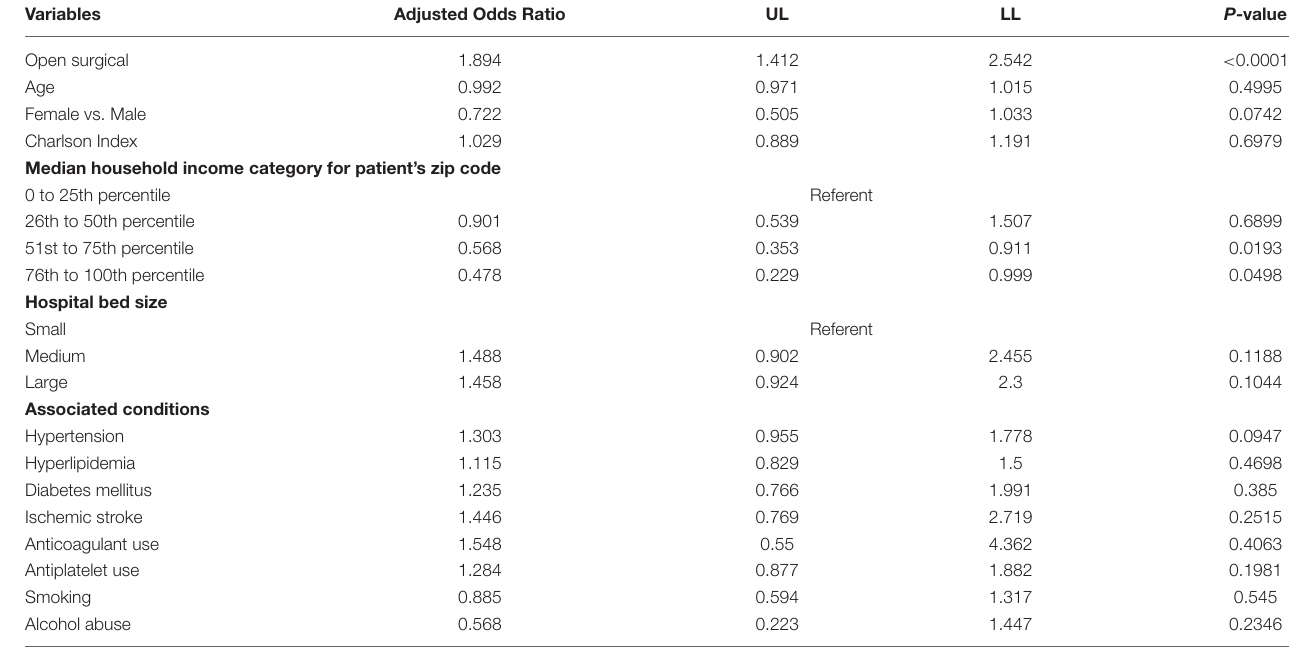
TABLE 3 | All patients (surgical and endovascular) readmission model and potential contributory factors.